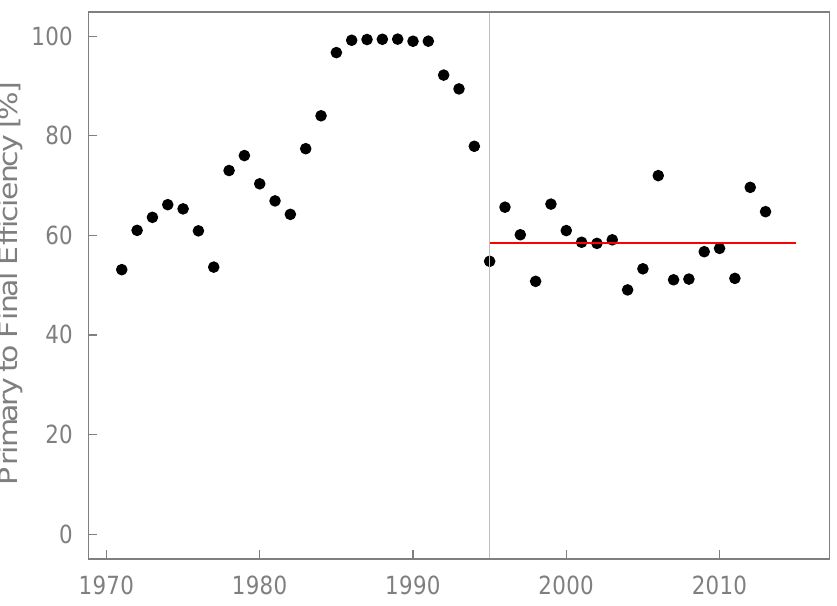
Figure 6. Primary-to-final efficiency for Electricity production in Honduras from 1971 to 2013. A horizontal line at 58.5% indicates the average efficiency from 1995 to 2013, which was assumed to be the primary-to-final efficiency of electricity production from 2013 to 2050. Total primary energy consumption was calculated from the predicted final energy consumption and the primary-to-final conversion efficiency shown in Table